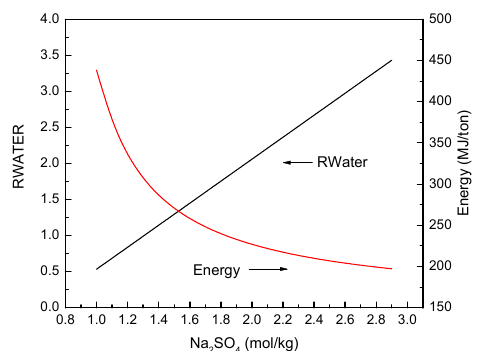
Figure 8. The effect of draw solution concentration on the FO process performance using Na 2 SO 4 as draw solute.